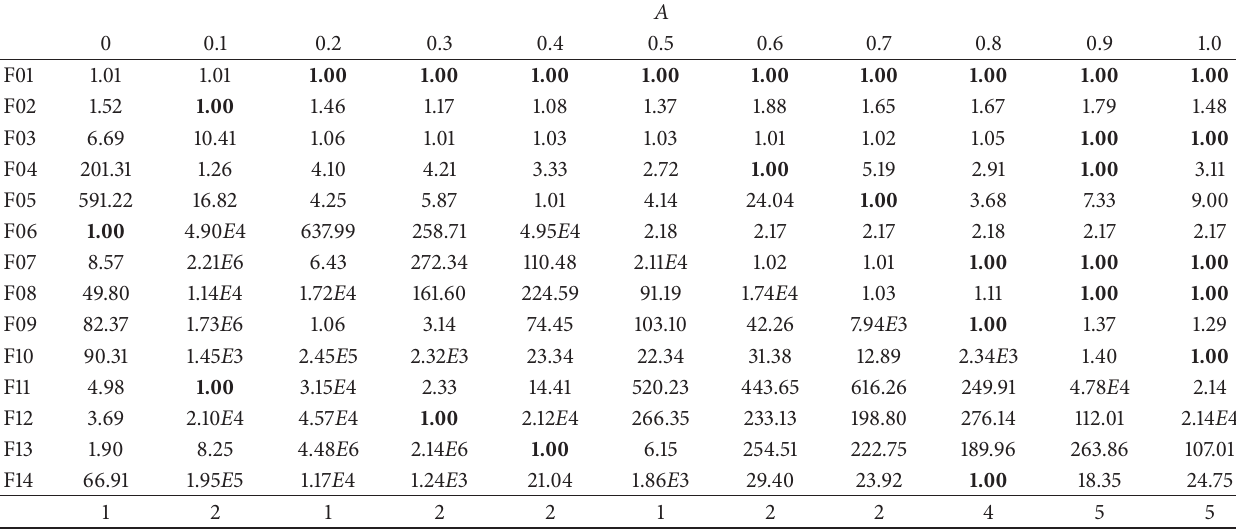
Table 6: Mean normalized optimization results in fourteen benchmark functions with different A . The numbers shown are the minimum objective function values found by HS/BA algorithm, averaged over 100 Monte Carlo simulations.